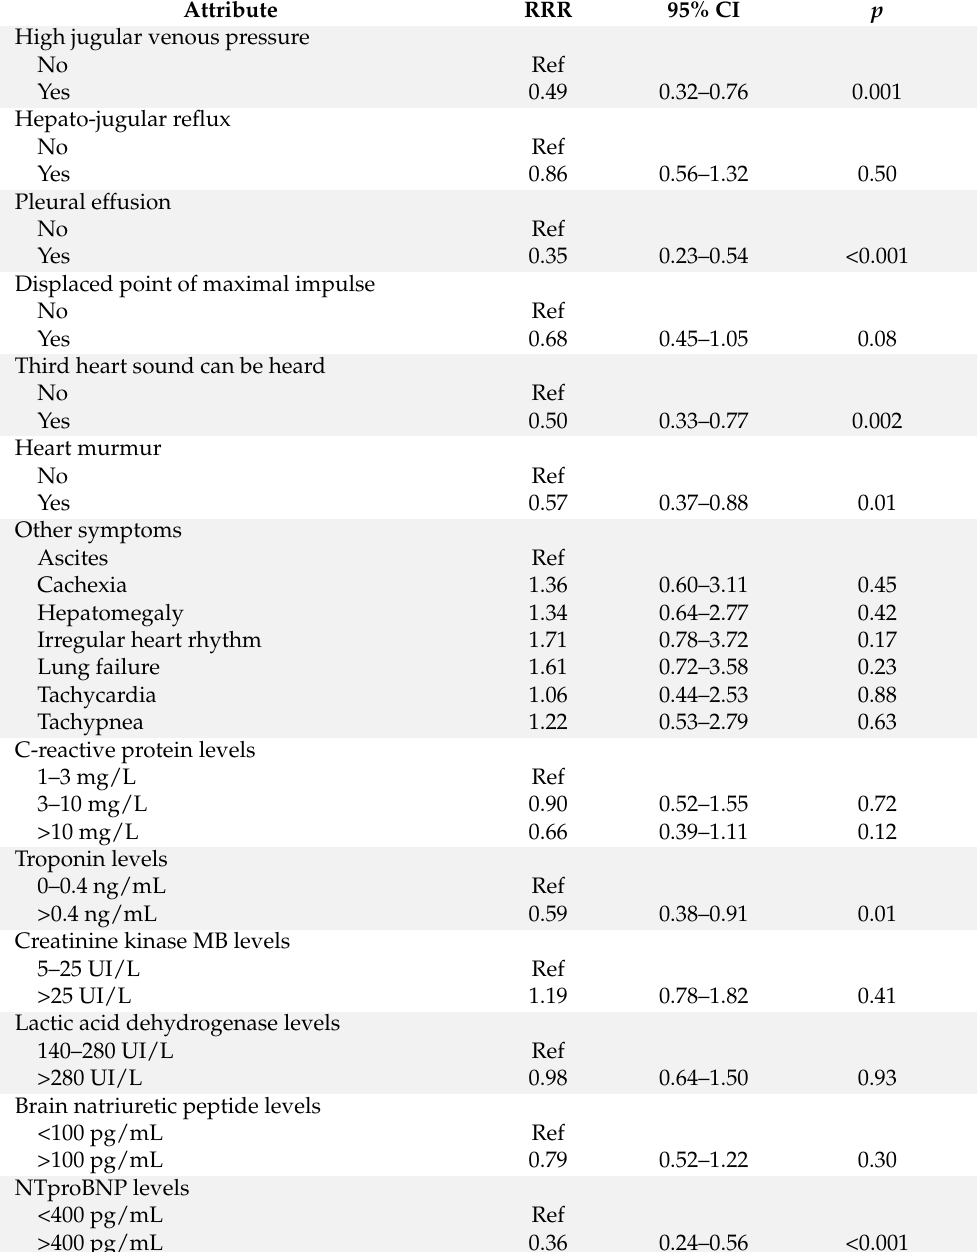
Table 5. Determinants of heart failure diagnosis—clinical examination